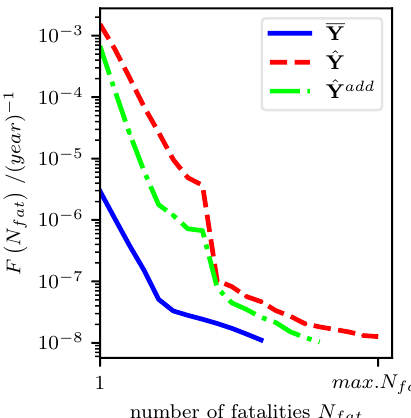
Figure 9. Effect of the metamodel uncertainty on the frequency F of scenarios with N fat fatalities when the drawback of the prediction interval method is reduced in ˆ Y mps by adding additional data points with the expected